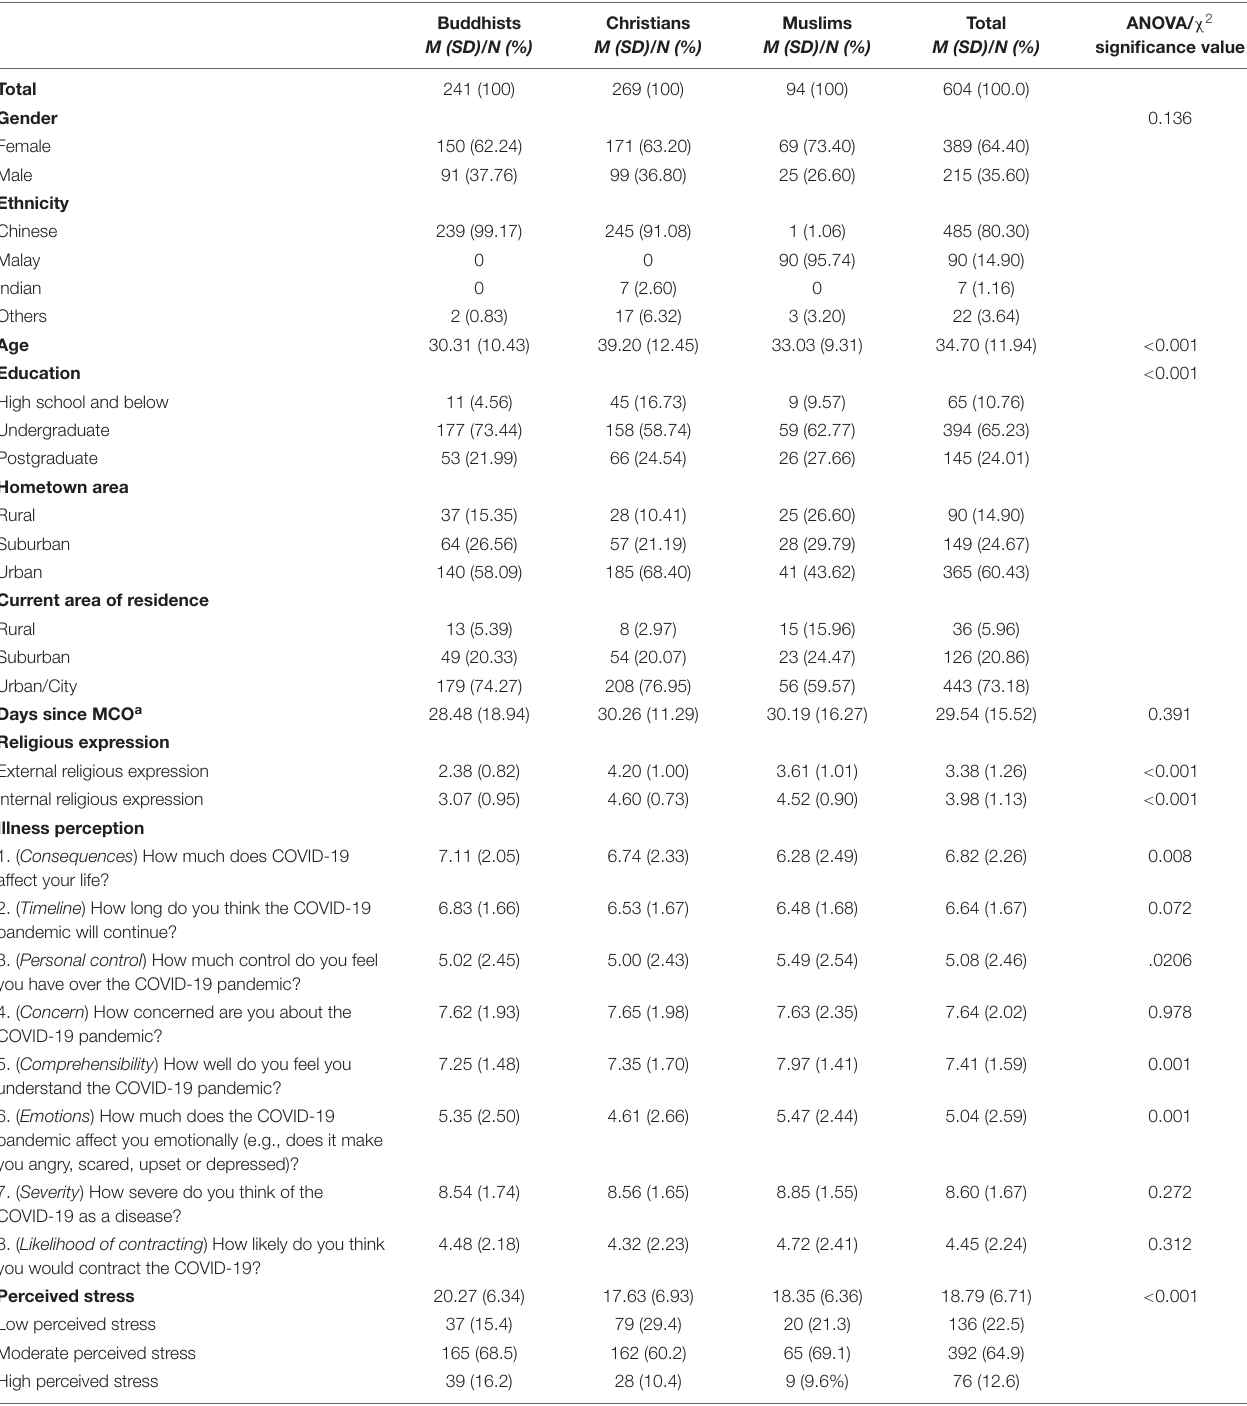
TABLE 1 | Sociodemographic background and descriptive statistics of participants from different religious